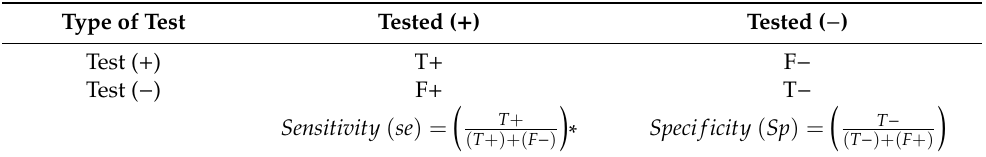
Table 1. Calculation of diagnostic sensitivity and